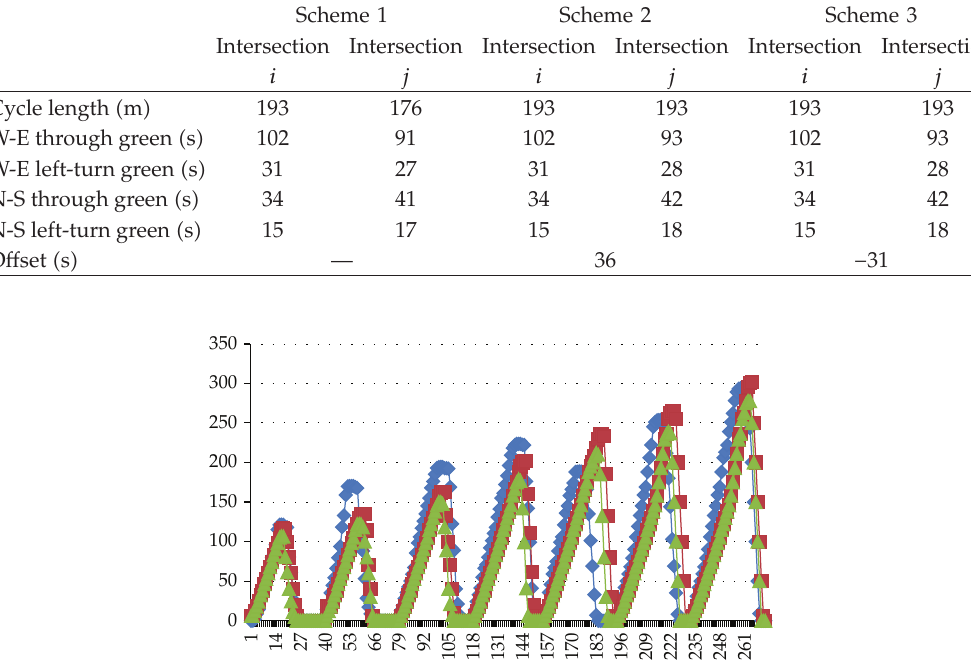
Table 2: Signal timing parameters of the 3 simulated schemes.